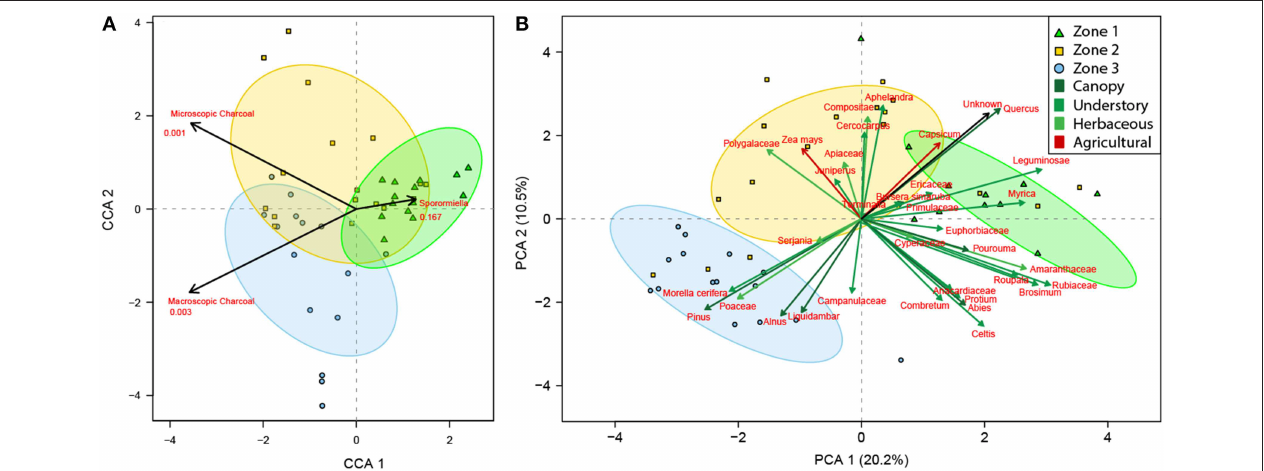
FIGURE 4 | Canonical correspondence analysis of the palaeopalynological data set ordinated against independent environmental indicators of local fire (macroscopic charcoal), regional fire (microscopic charcoal), and herbivory ( Sporormiella ) (A) . Principal component analysis of the palaeopalynological data set (B) . Zones are derived from the broken stick model and are represented by ellipses at a confidence of 95%. Zone 1 = green triangles; Zone 2 = yellow squares; Zone 3 = blue circles.